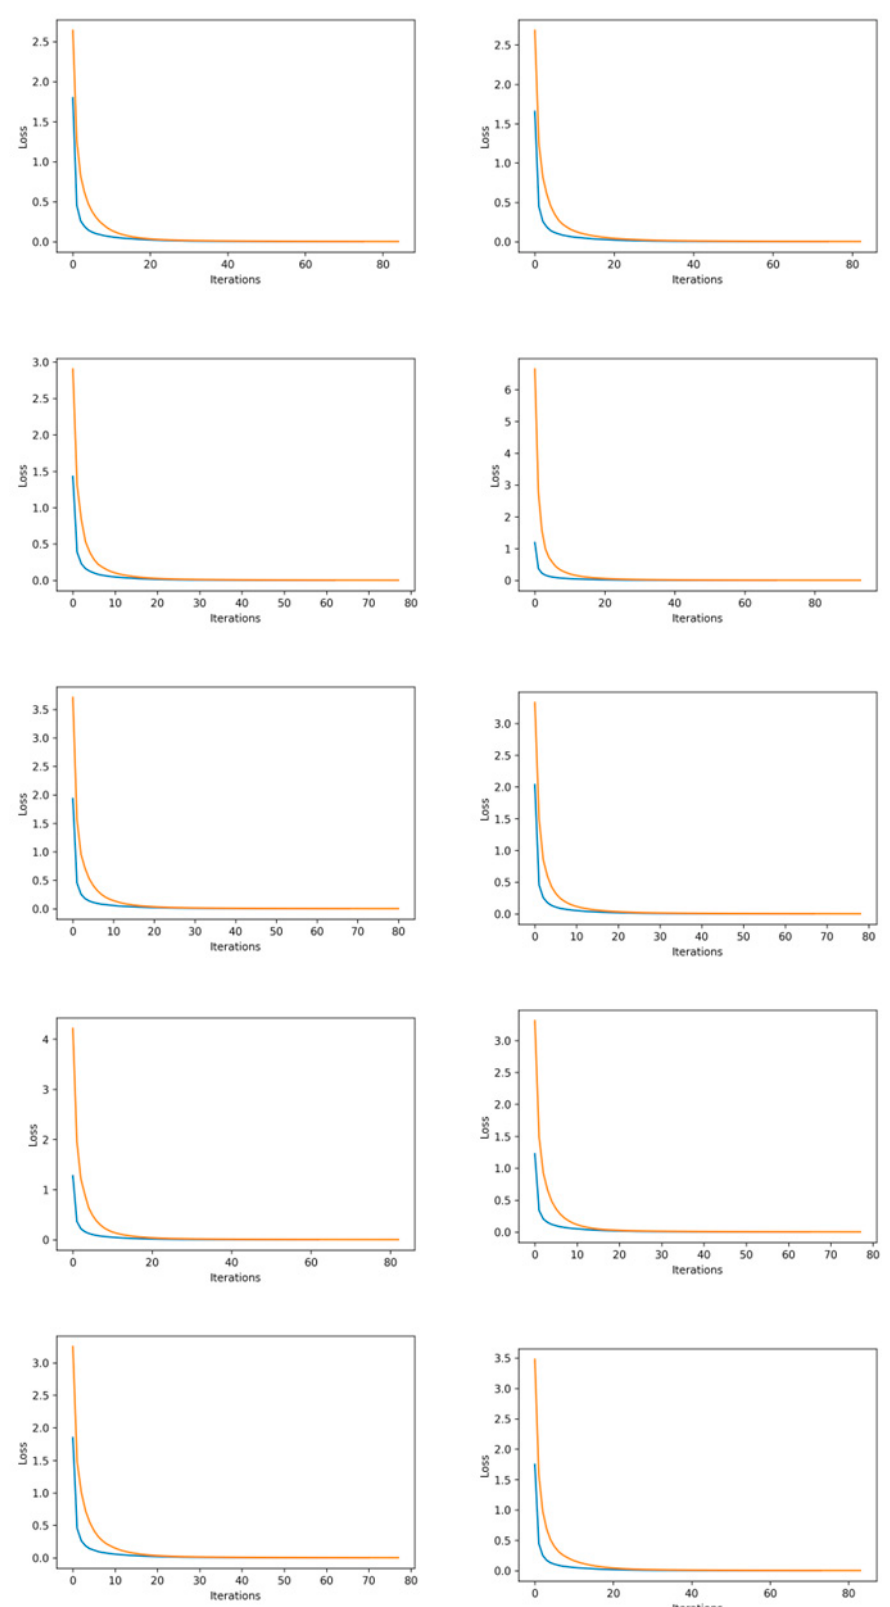
Figure 5. Training and validation curves for 10-fold cross-validation. Orange curves are for training, while blue curves are for